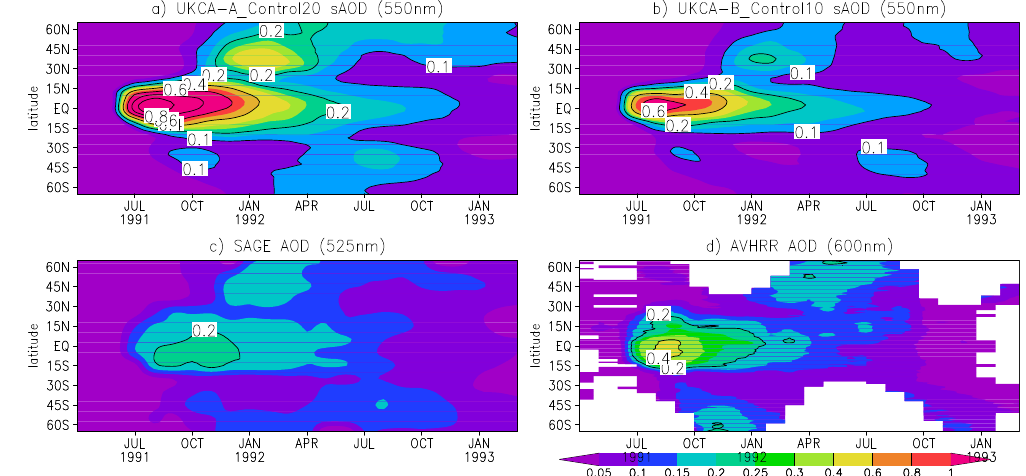
Figure 4. Time series of model-simulated zonal mean sAOD at 525nm (calculated by integrating the extinction above the tropopause) for runs (a) A_Control20 and (b) B_Control10. (c) and (d) show the sAOD measured by SAGE II (525nm) and derived from AVHRR (600nm) measurements. AVHRR sAOD is derived as the difference from the background total AOD from the 2 years before the eruption (Long and Stowe,